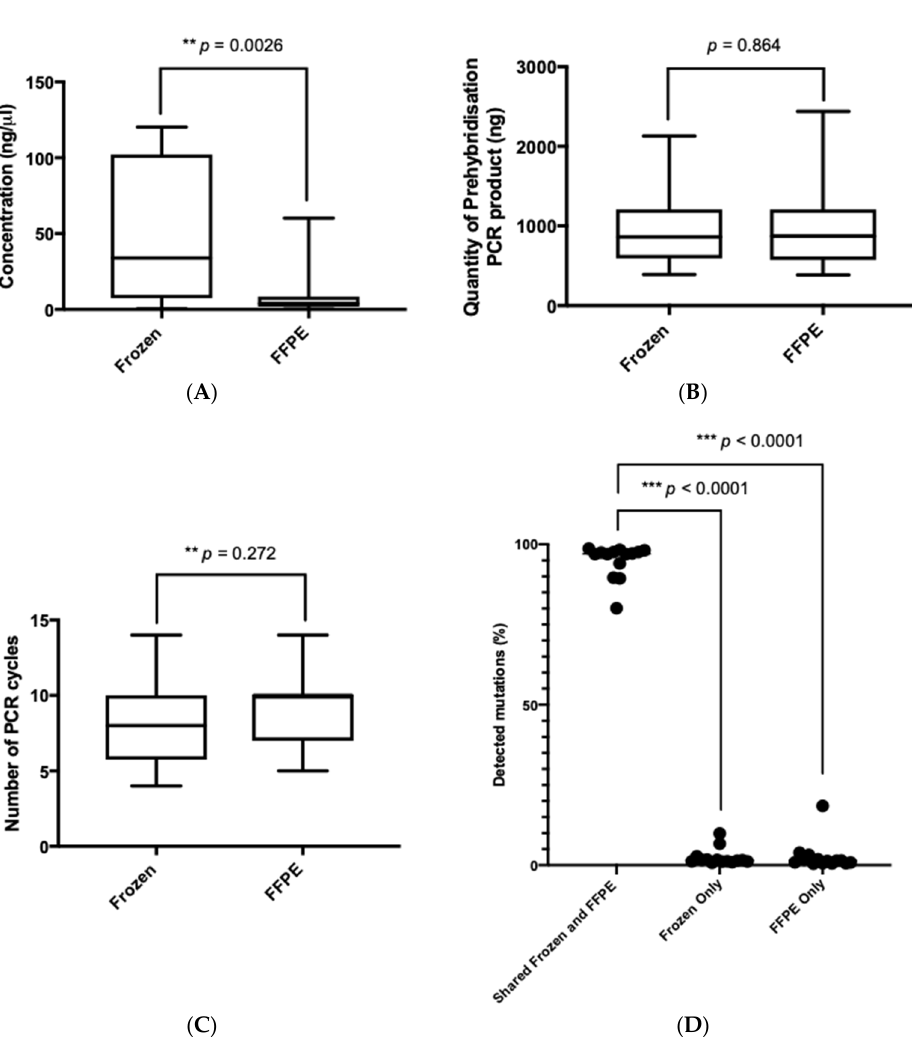
Figure 1. Mutational concordance between frozen and formalin-fixed paraffin-embedded (FFPE) gastro-oesophageal tumour samples. Box and whiskers plots showing the distribution of ( A ). The concentration of double-stranded DNA (nanograms per microlitre) extracted from FFPE and frozen gastro-oesophageal tumours. An increased double-stranded DNA yield was extracted from frozen tumour tissues compared with FFPE tissue ( p = 0.0026,) ( B ). Prehybridisation PCR product (nanograms) ( C ). The number of PCR cycles required to generate the pre-hybridisation library from FFPE and frozen gastro-oesophageal tumour samples. No difference between FFPE and frozen samples was observed in terms of the overall quantity of pre-hybridisation PCR product generated, nor in terms of the number of PCR cycles required to generate the pre-hybridisation library prior to sequencing ( D ). Bar graph showing a high mutational concordance (range 80.1% to 98.68%) in terms of the percentage of shared mutations detected (in both frozen and FFPE samples) compared with mutations unique to frozen samples and FFPE samples.